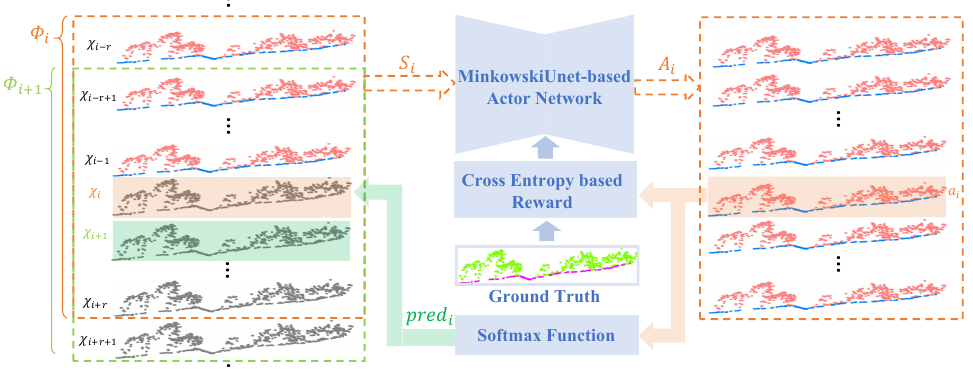
Figure 4. Overview of sequential ground prediction based on deep reinforcement learning. The S , A , χ , and φ denote the state, action, points-profile, and profile-stack,